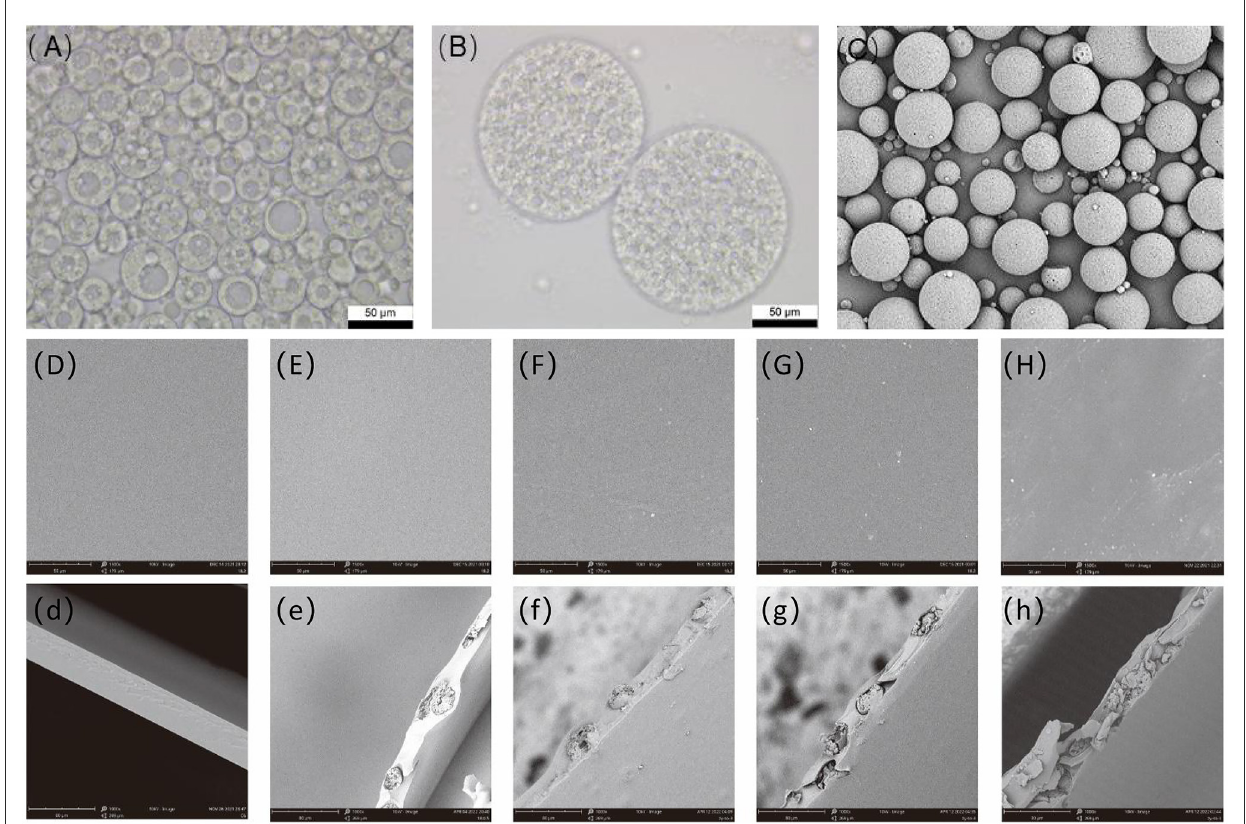
FIGURE1 SEM of optical micrograph of the double emulsion under the optimal process (A, B) , scanning electron microscopy of microcapsules (C) , and antibacterial film with different microcapsule addition amount, (D) microcapsule addition amount is 0%, (E) microcapsule addition amount is 5%,